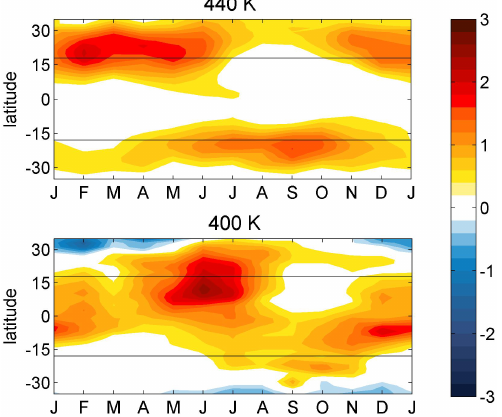
Fig. 9. Mean seasonal cycle (monthly means) of ozone relative ten- dency due to isentropic transport at 440K and 400K as a function of latitude. Tendencies are divided by the local annual mean con- centration. Horizontal black lines indicate the location of 18 ◦ S and 18 ◦ N latitudes. Units: (%day − 1 ).